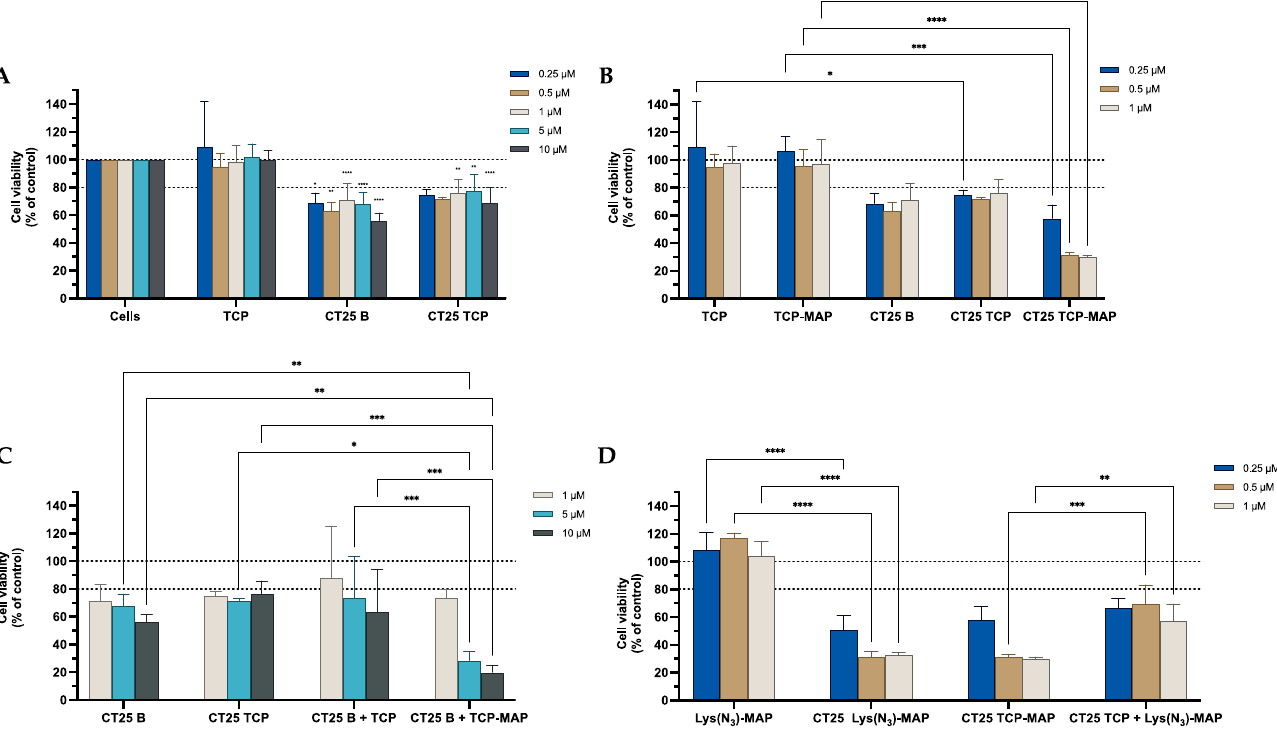
Figure 3. Relative cell viability of Caco-2 cell line measured by the MTT reduction after 24 h incubation. ( A ) represents NLC safety test with the treatment of free TCP, blank CT25, and TCP-loaded CT25 (0.25–10 µ M). ( B ) Represents differences in the cell viability of treatment with free TCP, TCP-MAP, blank CT25, TCP-loaded CT25, MAP, and TCP-MAP-loaded CT25 (0.25–10 µ M). ( C ) Represents co-administration of TCP and TCP-MAP with blank CT25 (1–10 µ M). ( D ) Represents the data obtained from the encapsulation of Lys(N 3 )-MAP and co-encapsulation of TCP and Lys(N 3 )-MAP in the NLC compared with peptide conjugate. Results are expressed as mean ± SD (n = 4). Statistical analysis between the groups was performed using two-way ANOVA with Tukey’s multiple comparisons test (* p < 0.05; ** p < 0.01; *** p < 0.001; **** p < 0.0001).